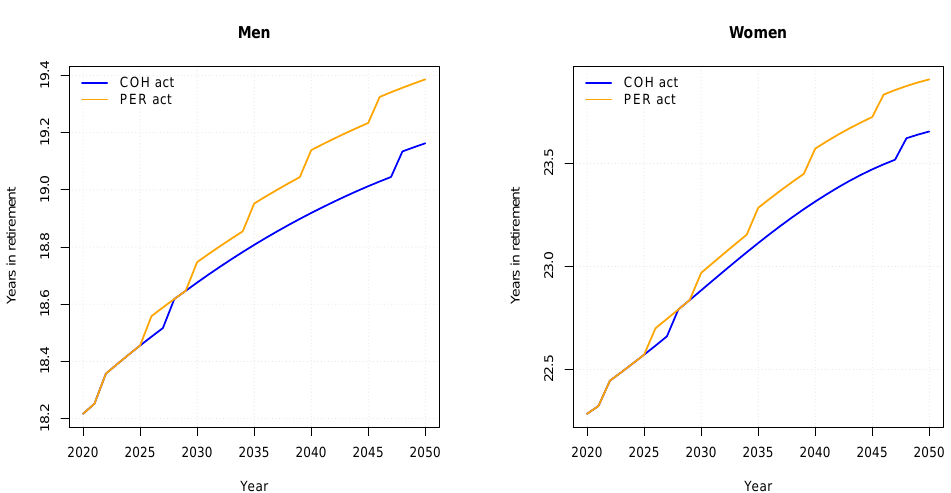
Figure 9. PRT: Expected years in retirement for each sex based on period and cohort projections. Table 4. PRT: Forecast of life expectancy and pension age